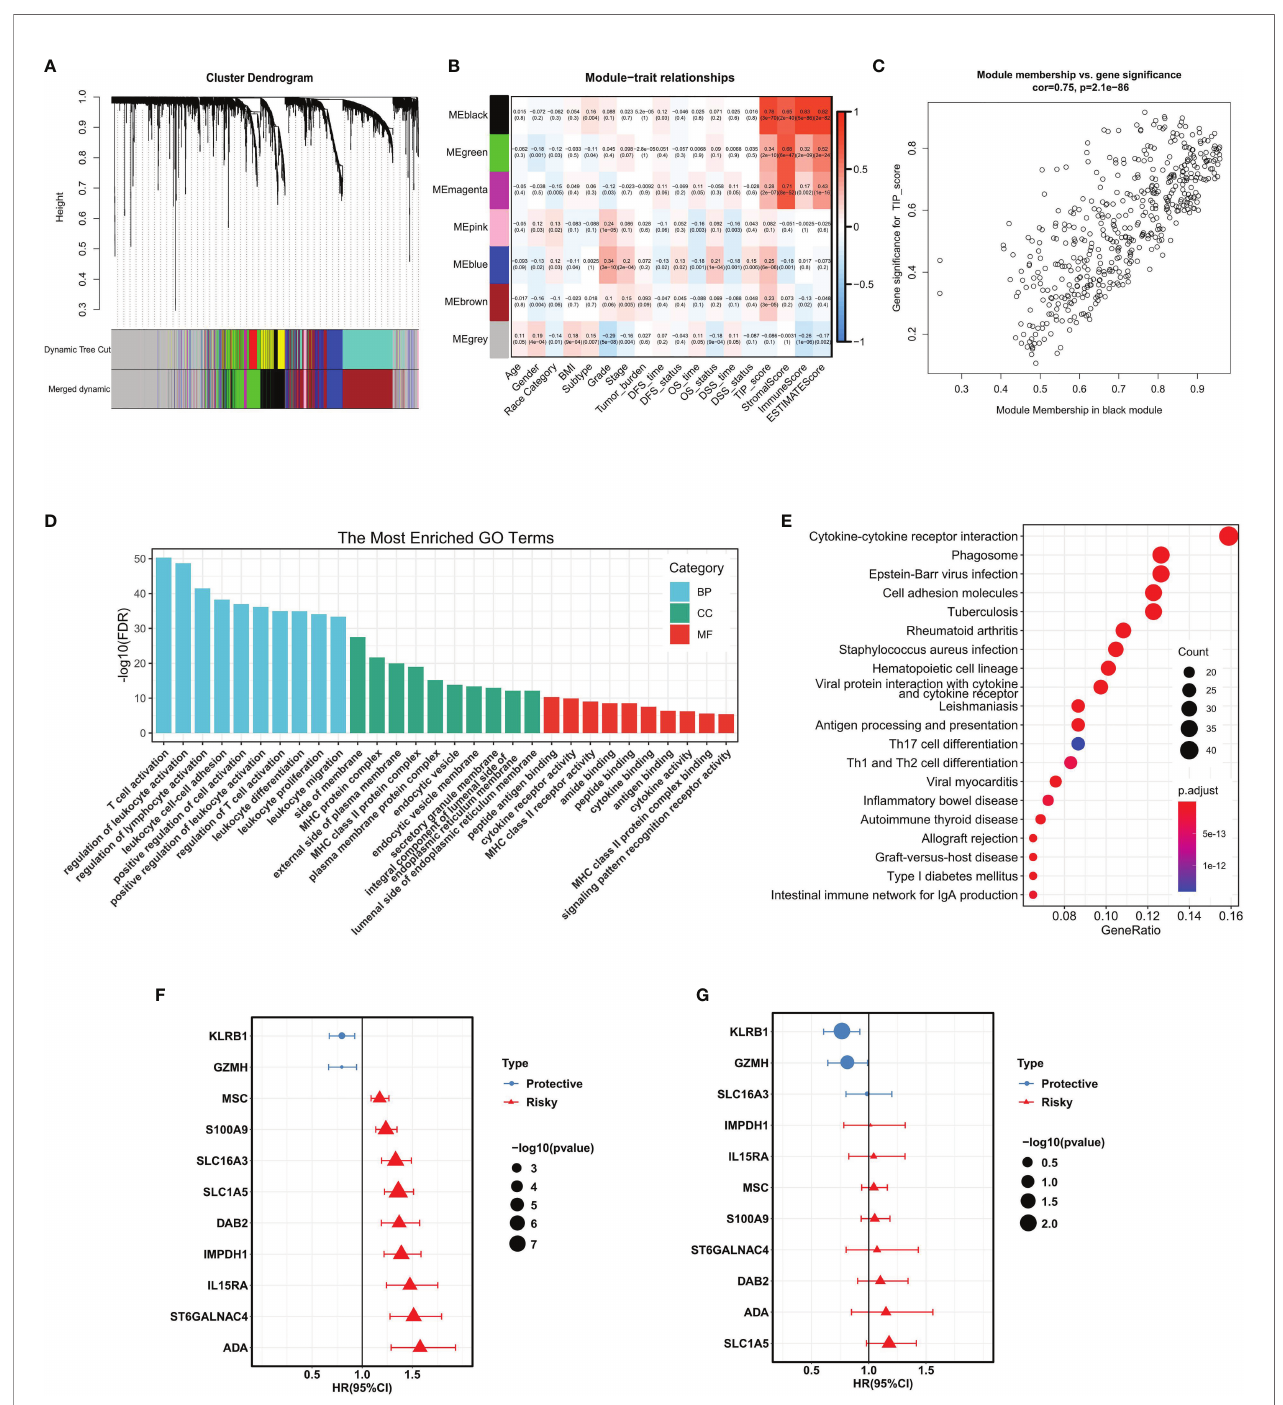
FIGURE 3 | WGCNA analysis and the construction of TIPRGPI for HCC. (A) Cluster dendrogram of MAD top 5000 genes. (B) Table cells showing Pearson ’ s correlation coef fi cients and corresponding P -value between module eigengenes (ME) and the variables. (C) Scatter plot showing the relationship between gene signi fi cance (GS) for TIP score and module membership (MM) in the black module. (D, E) GO enrichment analysis (D) and KEGG (E) enrichment analysis for the black module genes. (F, G) Hazard ratio with 95%CI of each gene in the TIPRGPI signature computed by UniCox and MultiCox, respectively. GO, gene oncology; KEGG, Kyoto Encyclopedia of Genes and Genomes; WGCNA, weighted gene co-expression network analysis; MAD, median absolute deviation; TIPRGPI, TIP- related gene prognostic